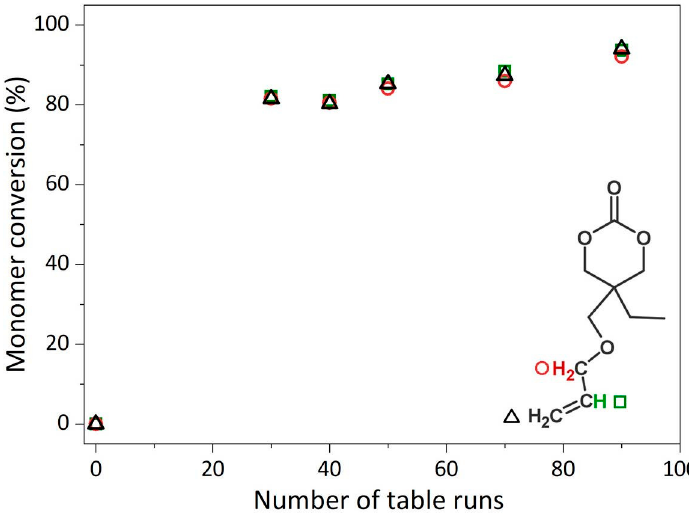
Figure 4. Conversion of the allyl group in function of plasma exposure time (number of table runs) calculated based on the signals from the protons of the allyl group (=CH 2 , triangle and =CH-, square symbols) and the α -carbon (-CH 2 -, circle symbol) in the 1 H NMR spectra. The integral of the protons of the methyl group were considered as internal reference for the